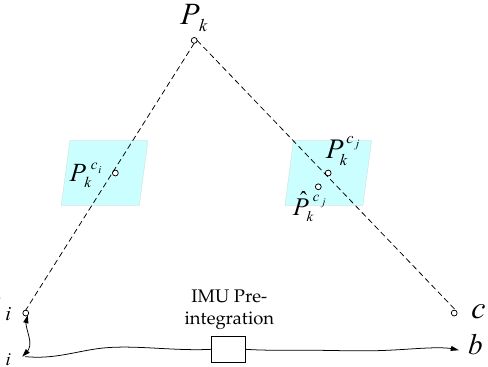
Figure 3. Point feature reprojection residuals diagram.